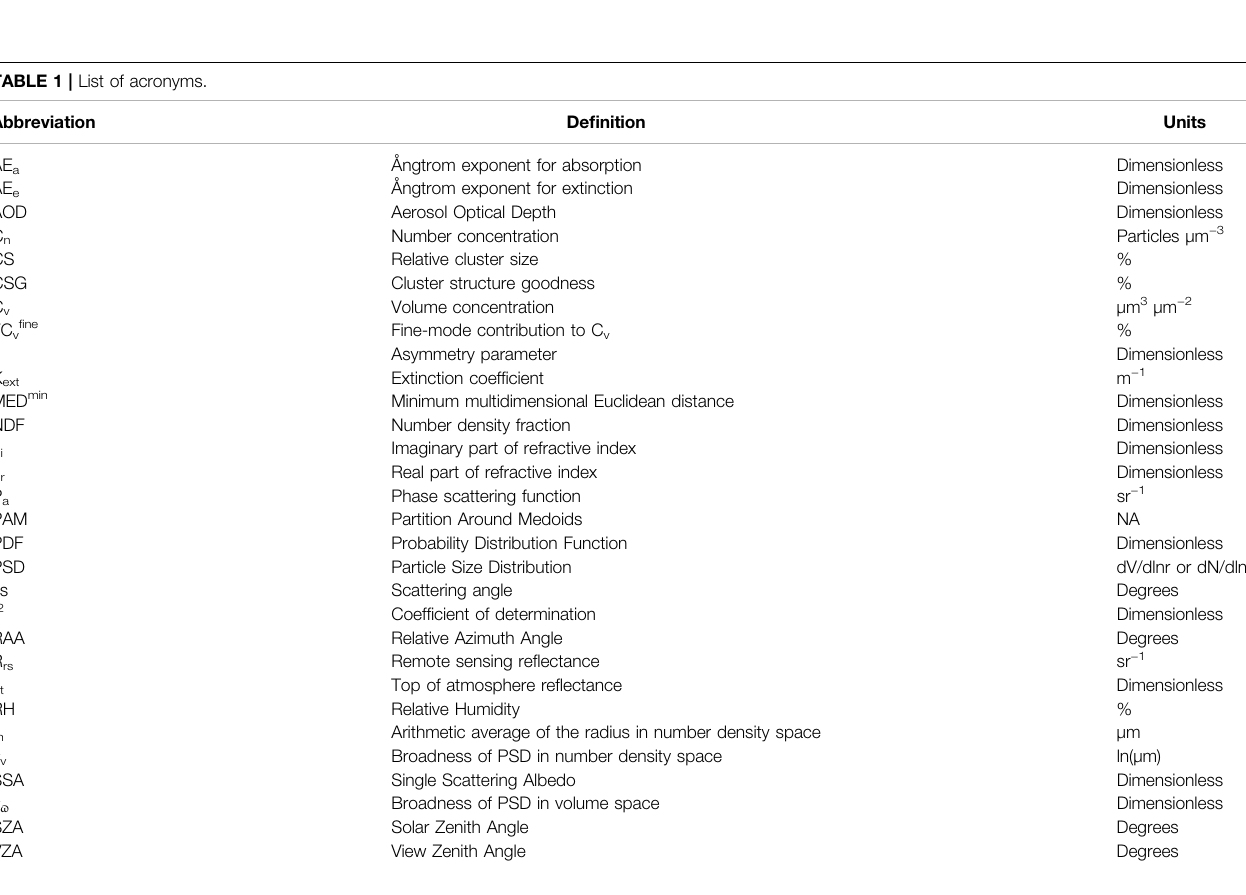
TABLE 1 | List of